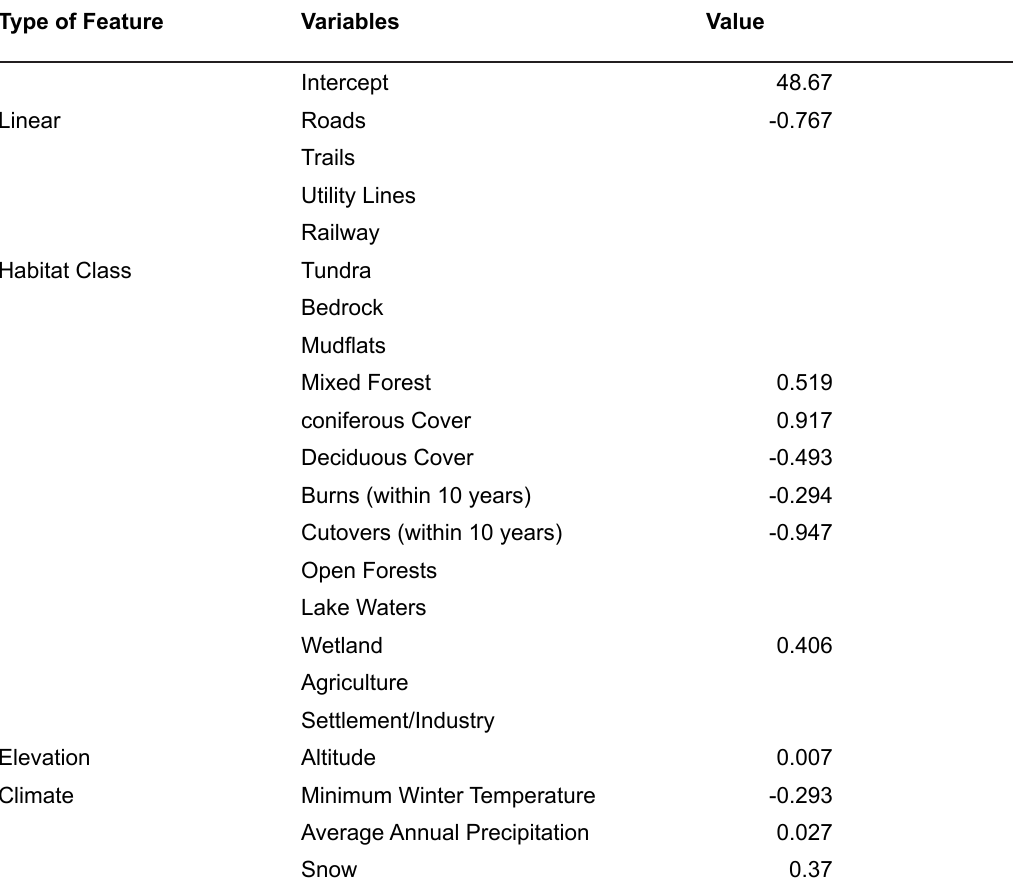
Table 1. Significant ( p <0.05) coefficient values for the logistic regression model. Those with no value indicate that the predictor does not significantly contribute to caribou occurrence in